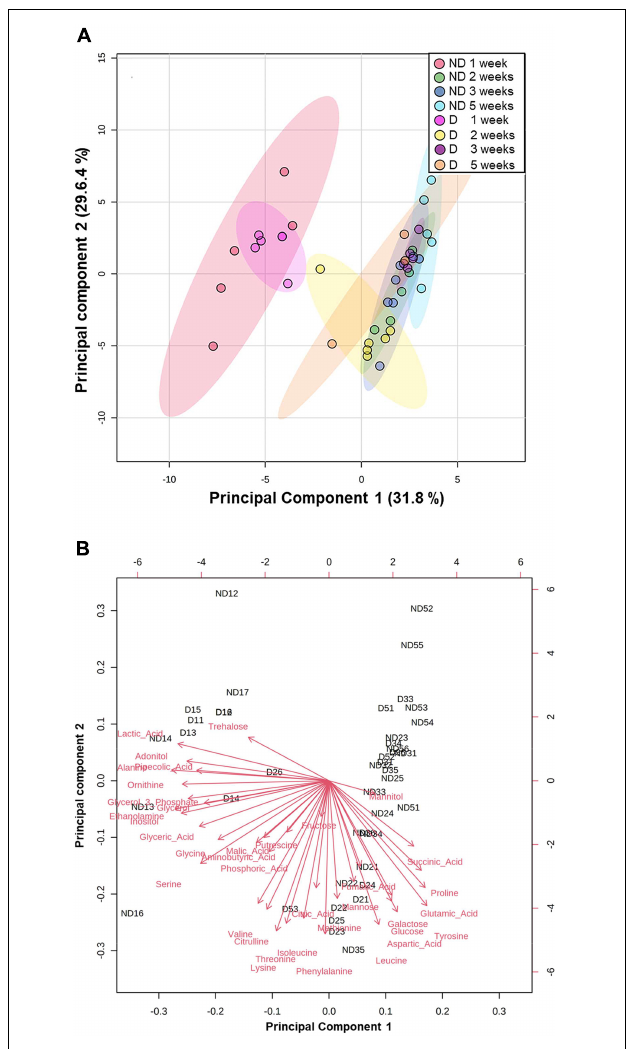
FIGURE 3 | Principal component analysis (PCA) score plots of metabolites data from adult Alphitobius diaperinus on the first two principal components (PC1 and PC2) (A) PCA of metabolite data from food-deprived beetles exposed at 60% RH (No Desiccation, ND) or 10% RH (Desiccation, D) for 1, 2, 3, or 5 weeks. Colored dots represent individual samples. Colored ovals represent 95% confidence intervals. Percentages of total variance of PC1 and PC2 are presented in parentheses. (B) Biplot of the PCA. Red arrows represent individual metabolite loading vector; the magnitude (distance from the origin) and direction of the loading vectors demonstrate the contribution of each metabolite to sample clustering. The loading plots graphing the coefficients of each metabolite for the first and second components of the PCA are presented in Supplementary Appendix 1 . Samples Id read as follows: ND = beetles exposed at 60% RH; D = beetles exposed at 10% RH. The first number refers to the duration of exposure (in weeks); the second number corresponds to the numbering of the samples. For example, ND35 means the 5th replicate of the beetles that were exposed at 60% RH for 3